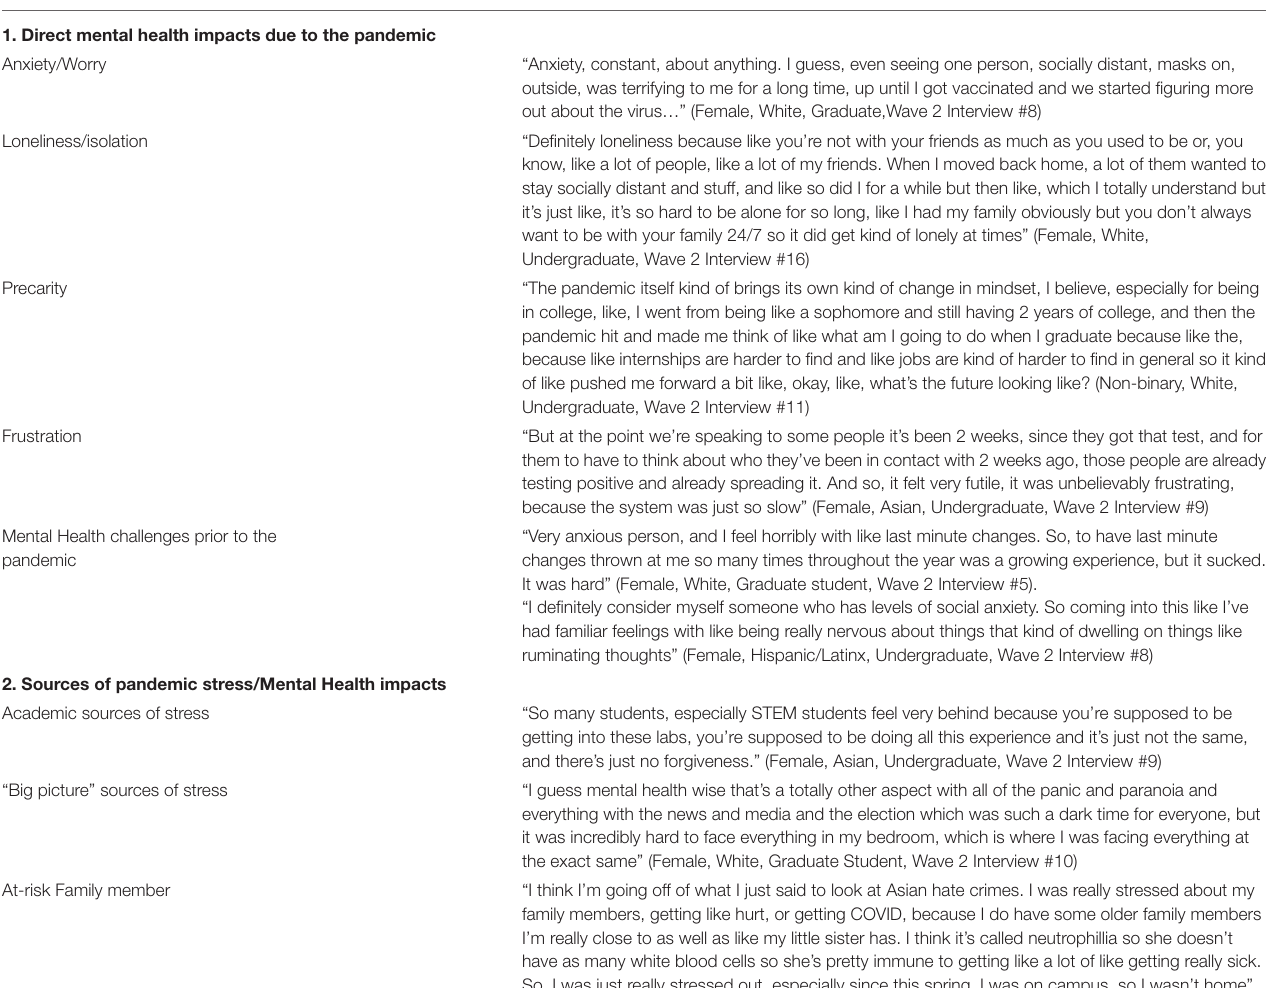
TABLE 2 | Themes and subthemes with supportive